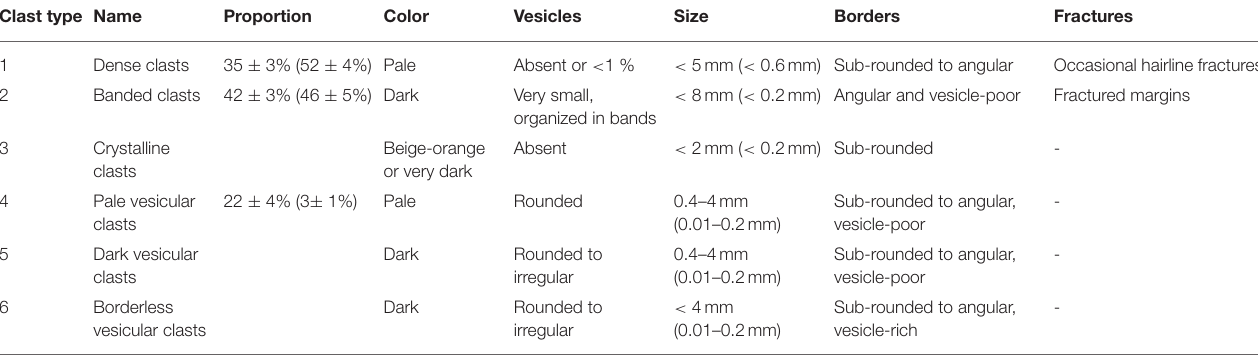
TABLE 2 | Detailed clast classification within the main tuffisite vein